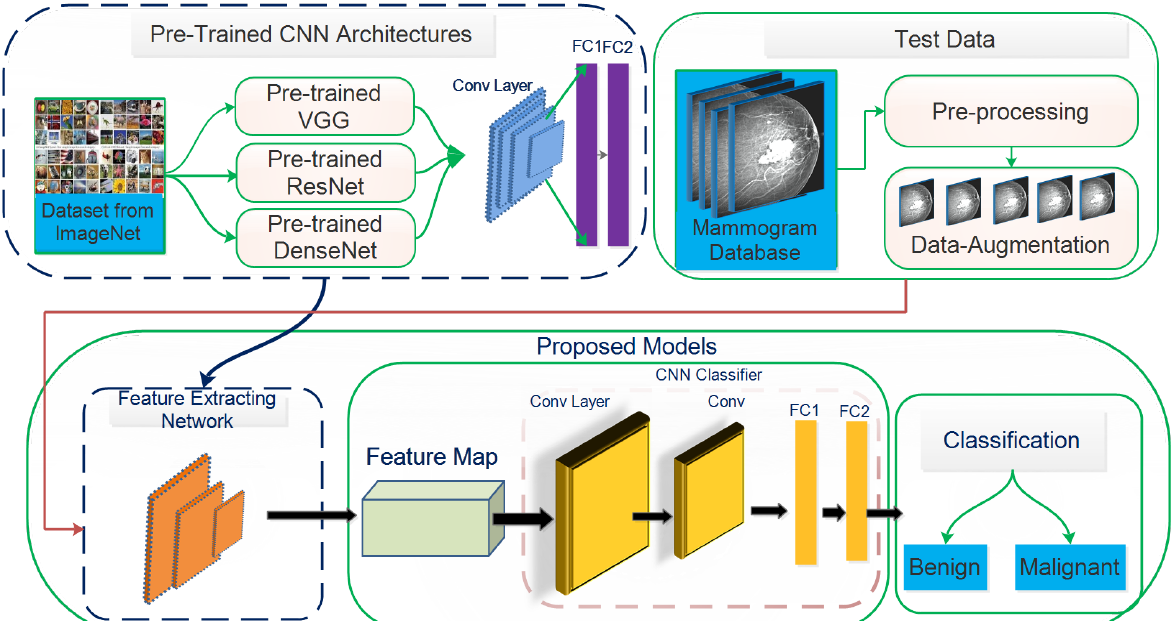
Figure 1. Step wise illustration of the transfer learning for deep CNN-based architectures, which contain blocks. (1) DCNN models are pre-trained on real images from Image-Net and used as feature extractors. (2) The data are pre-processed with a median filter to remove noise, then CLAHE enhances the images. (3) Data augmentation increases the number of the data samples, and (4) fine-tuning to share the properties of the DCNN model by transfer learning. (5) The final prediction is obtained by modifying the weights of the lower layer of pre-trained models to extract general features and fine-tuning the higher layer using global average pooling to attain a particular